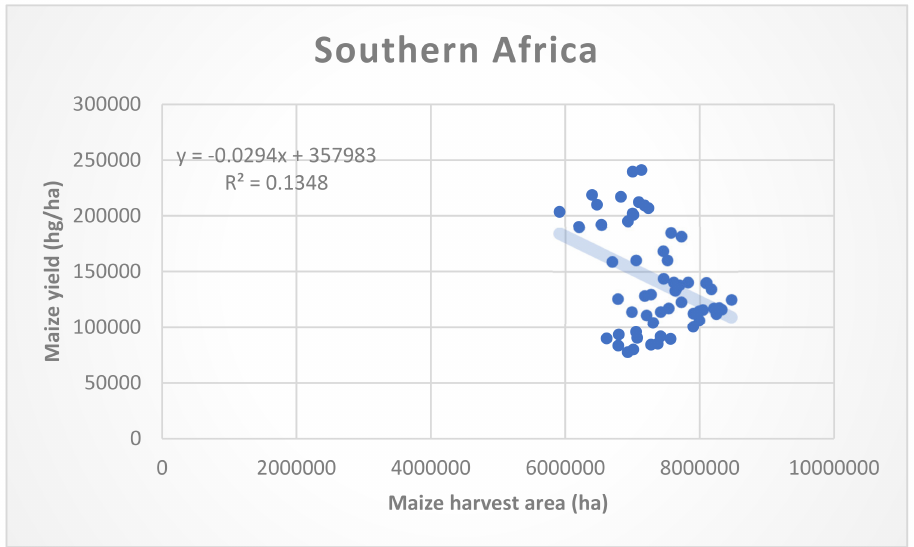
Figure 9. Scatter plot of the relationship between maize yield and harvest area in South